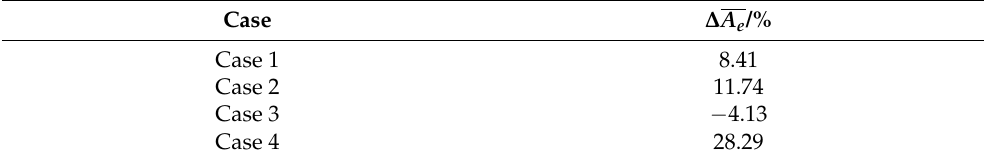
Table 5. The Δ 𝐴 (cid:3032) (cid:3364)(cid:3364)(cid:3364) of different non-axisymmetric endwalls . Table 5. The ∆ A e of different non-axisymmetric endwalls.